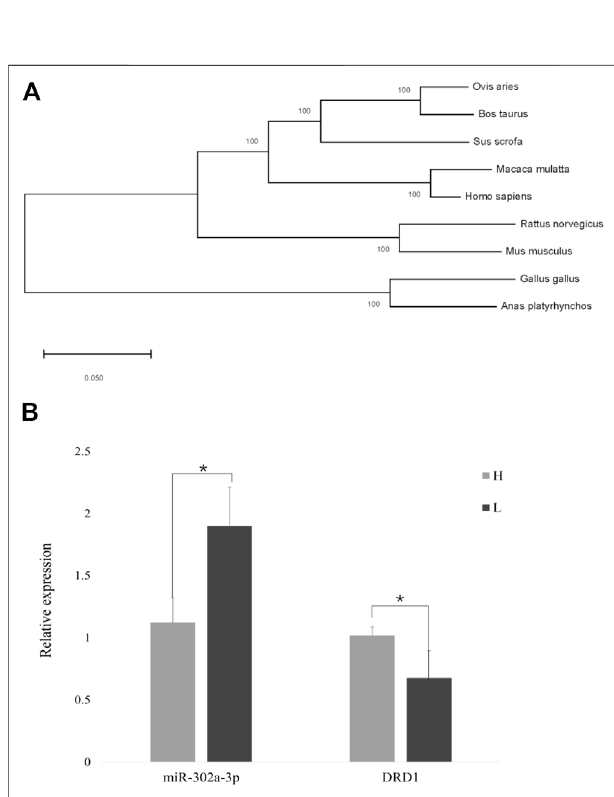
FIGURE 4 | (A) Cluster plot showing DRD1 conservation in various species. (B) Expression of DRD1 and miR-302a-3p in small yellow follicles of high – and low – egg-yielding Taihang chickens (* p <